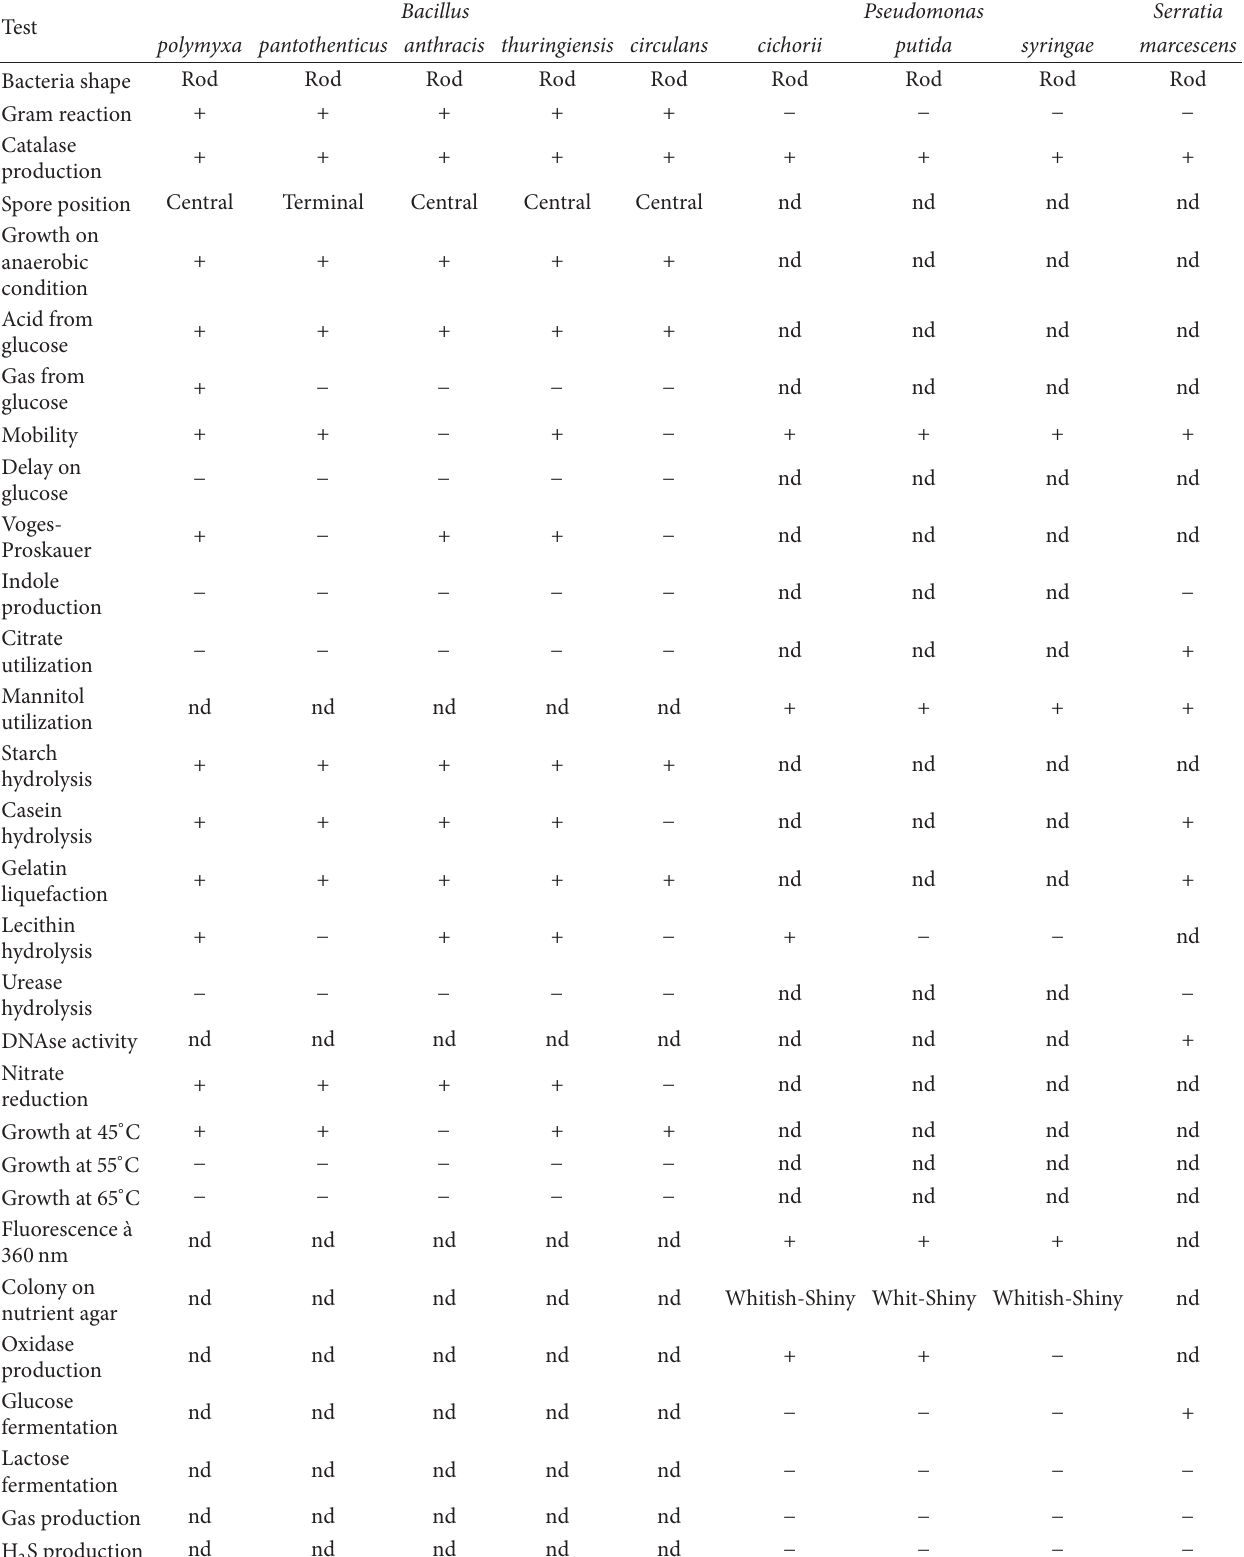
Table 2: Morphological and biochemical characteristics of rhizobacteria isolated from samples collected in the central and northern Benin.